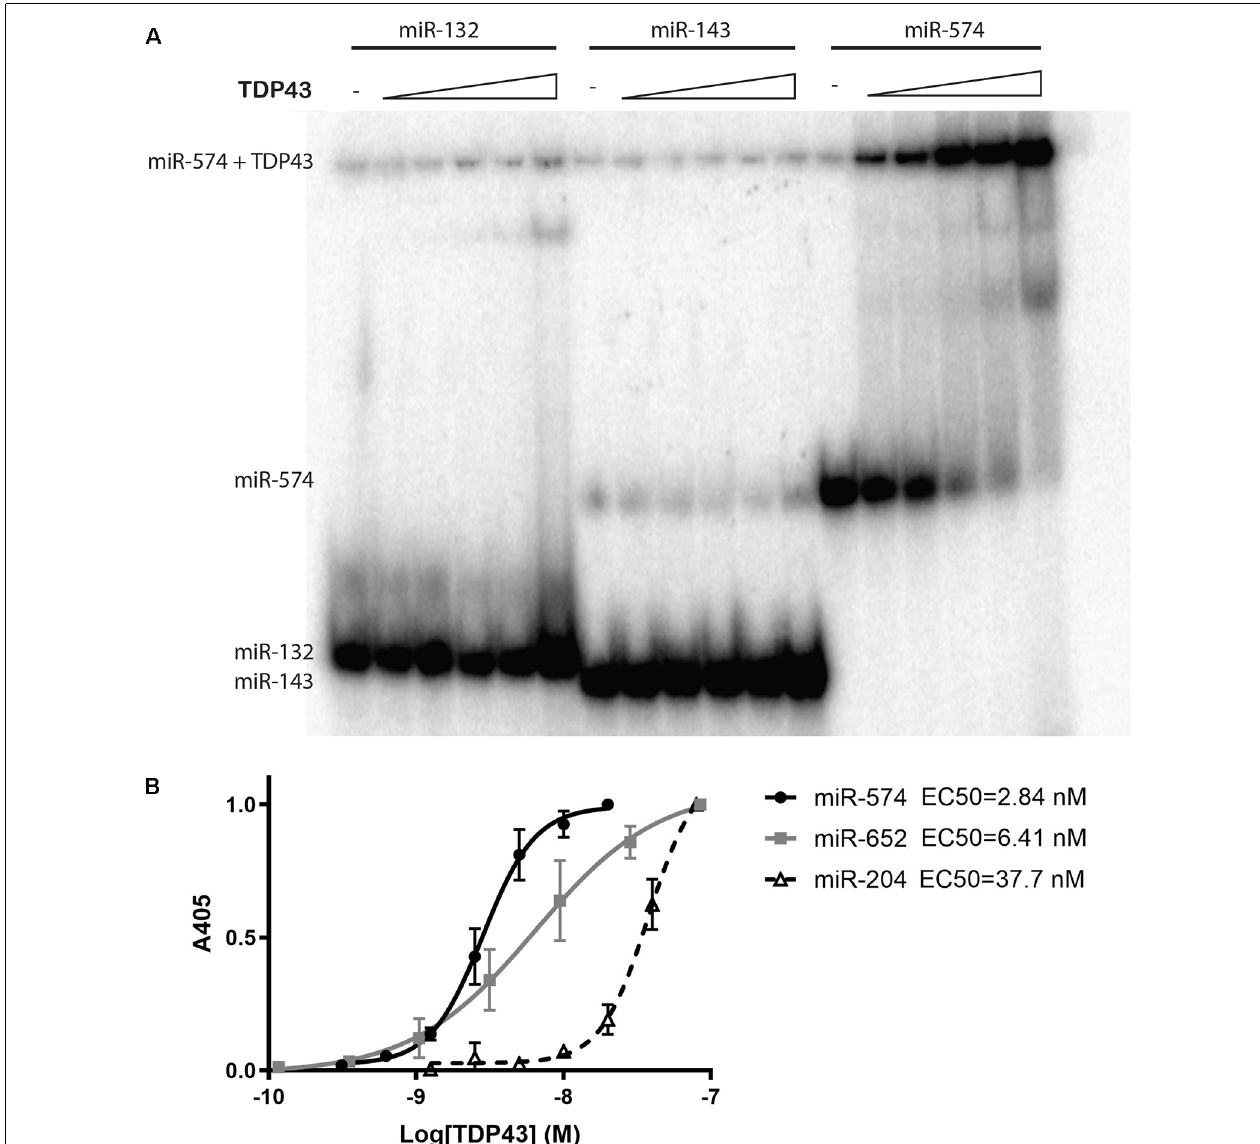
FIGURE 1 | Trans-activation response element DNA/RNA-binding protein of 43 kDa (TDP43) binding specificity and apparent binding affinities for select microRNAs (miRNAs). (A) A native gel mobility shift assay was used to evaluate the association between TDP43 and previously associated miRNAs: miR-132, miR-143, and miR-574. Trace amounts of 32 P-radiolabeled RNA (5 nM) were incubated with increasing concentrations of TDP43 (0, 0.05, 0.125, 0.25, 0.5, and 1.25 mM) and analyzed on a 12.5% native PAGE gel. A shift in band size was observed only for miR-574 (right). (B) Apparent binding affinities (EC50s) of TDP43 for select